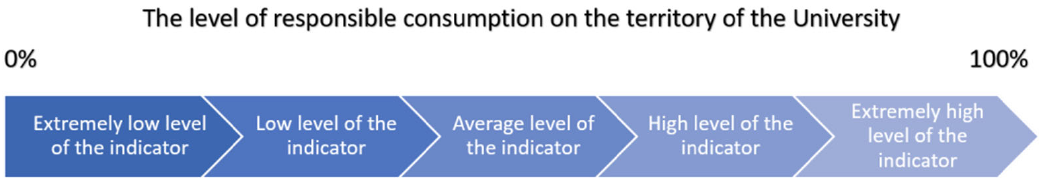
Figure 6. Visual expression of the level of responsible consumption.